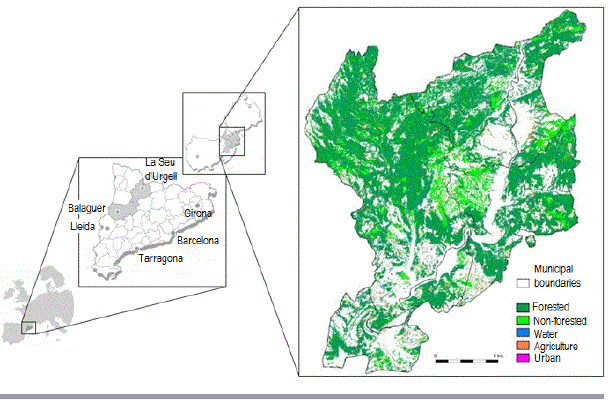
Fig. 1 . Forest cover change on the Rialb River Basin (1993– 2009). Grey maps obtained from http://www.segrerialb.cat/ show the location of the Rialb river basin within Europe and the region of Catalonia: names display sub-regional capitals. The forst cover change map was produced by the Centre of Forest Property of Catalonia from raster data (MCSC v1 & v4), obtained from the Catalan Forest Reaserach Institution